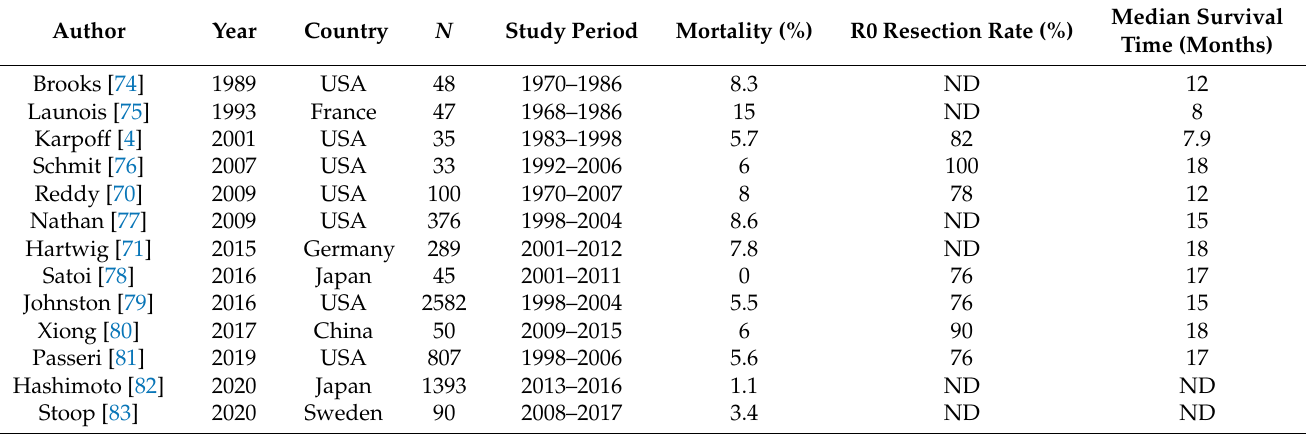
Table 4. Previous reports about total pancreatectomy for pancreatic